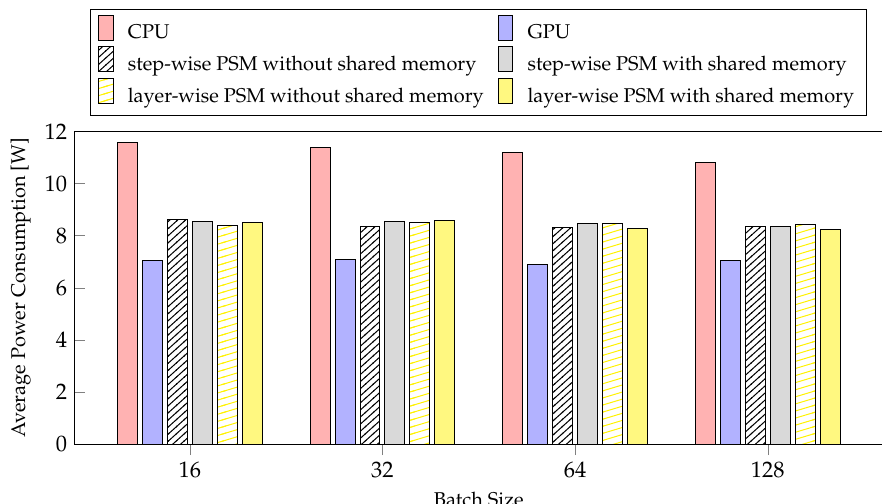
Figure 11. The experiments about average power of PSMs for training per batch